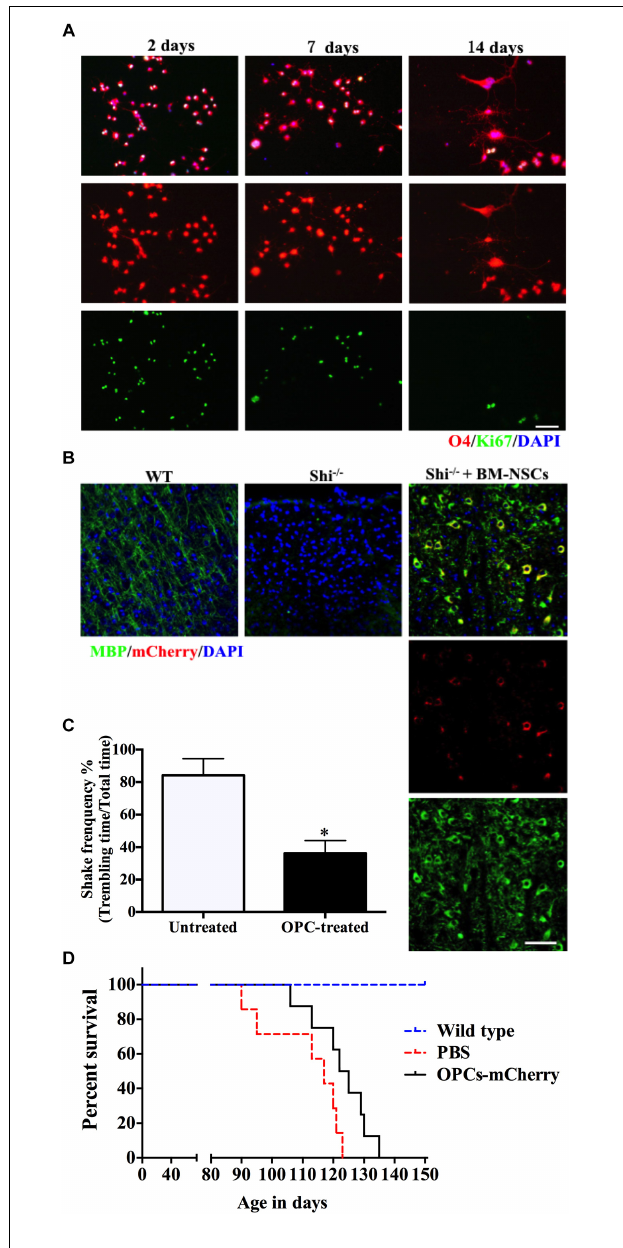
FIGURE 5 | BM-NSCs OLGs differentiation in vitro and transplantation in Shi mice. (A) BM-NSCs were cultured in oligodendrocyte differentiation media for 48 h, 1 week, and 2 weeks for O4 (differentiation marker) and Ki-67 (proliferation marker) staining. (B) Fluorescence staining of BM-NSCs (mCherry + cells), after 35 days post injection, show myelination (MBP + ) in the contralateral striatum. Scale bar = 50 µ m. (C) Quantification of tremor of Shi mice treated with OPCs. (D) Transplanted OPCs prolong the survival of Shi mice compared with PBS-treated ( n = 9). Symbols represent mean ± SD. ∗ p < 0.05, Student’s t